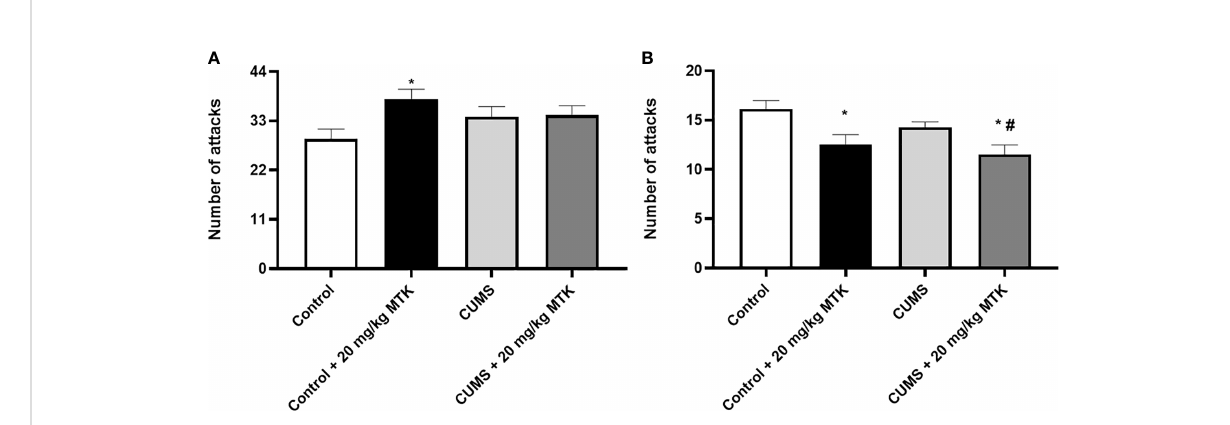
FIGURE 6 Effects of MTK on aggressive-like behavior. Male (A) and female (B) rats were exposed to CUMS or control conditions for four weeks and then, while remaining under these conditions, were treated with MTK 20 mg/kg or vehicle. Each column is the mean ± SEM of 12 to 18 rats per group. Using one-way ANOVA (with Benjamini – Hochberg False Discovery Rate), followed by Student ’ s t-test for speci fi c group comparisons: *p < 0.05 vs. Control + DMSO; #p < 0.05 vs. CUMS +